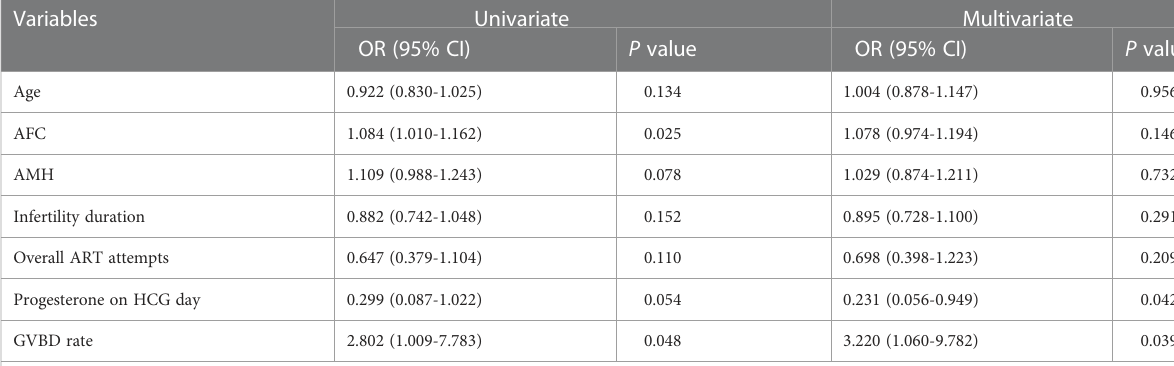
TABLE 2 Univariate and multivariate logistic